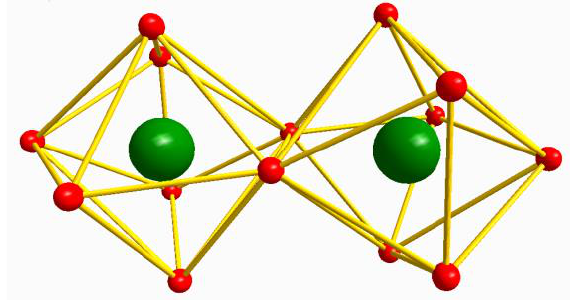
Figure 2. Local coordination environment of Dy ions in 1 . Color code: green – Dy; red – oxygen.